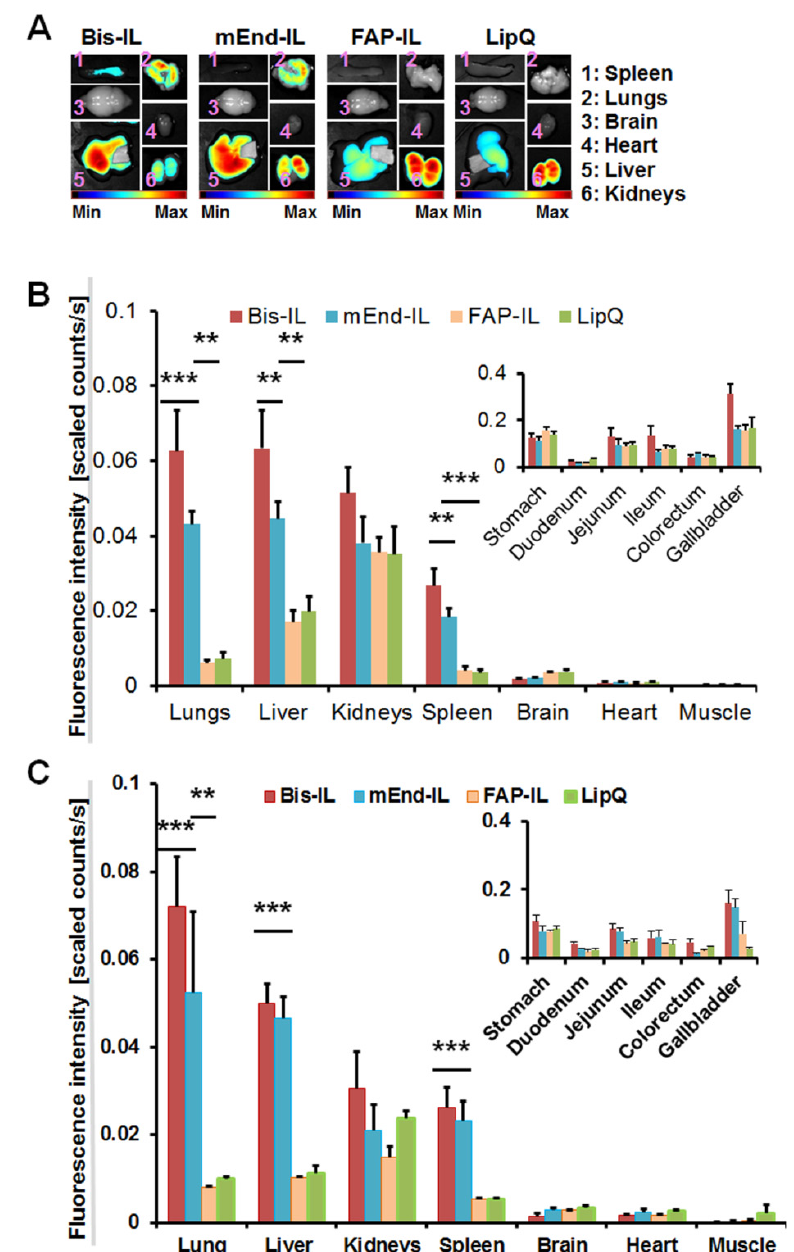
Figure 4. Biodistribution of liposomal formulations reveal target-specific alterations. ( A ) Representative near-infrared fluorescent (NIRF) images of organs from immune deficient athymic nude mice showing the DY-676-COOH signals 6 h p.i. of 20 µ mol (final lipids) / kg body weight of the indicated liposomes. Semi-quantitative levels of the DY-676-COOH based fluorescence intensities of the respective organs excised from ( B ) immune deficient athymic nude mice, and ( C ) immune competent NMRI mice 6 h post injection. Inlays: gastrointestinal tract of the respective mice. The mEdg’scFv bearing liposomes (mEnd-IL and Bi-FAP / mEnd-IL, abbreviated Bis-IL), reveal a higher (*** p < 0.001 and ** p < 0.01) retention in the lungs, liver, and spleen than the FAP-IL and the control LipQ. Each bar depicts the mean of n = 3 mice and the SEM.